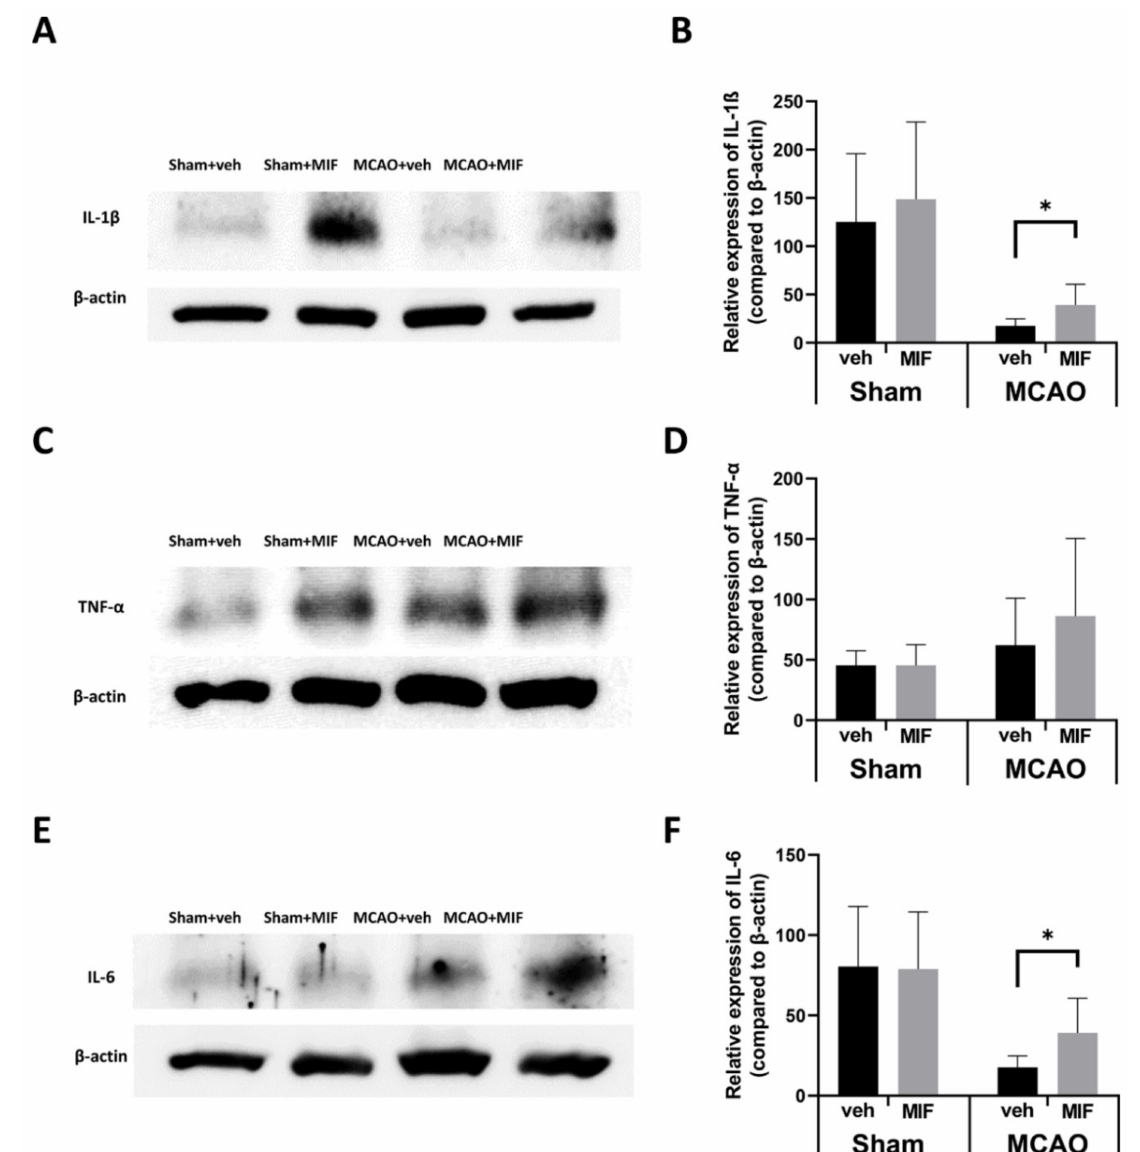
Figure 6. Changes of pro-inflammatory markers: ( A , C , E ) representative Western blot bands for each group; ( B ) expression level of IL-1 β between the sham+MIF and the sham+veh groups was not significantly different ( p = 0.909); the IL-1 β expression in the MCAO+MIF group was significantly facilitated compared to that in the MCAO+veh group (* p < 0.003); ( D ) the expression level of TNF- α expression was not significantly increased following MIF administration in the MCAO group ( p = 0.383) and in the sham group ( p = 0.992), respectively; ( F ) IL-6 expression in the MCAO+MIF group was significantly increased compared to the MCAO+veh group (* p < 0.004); there was no significant difference between sham groups ( p = 0.916). Pro-inflammatory marker expression of all sham and MACO groups was analyzed, respectively, with a t -test. Mean ± SD values are presented from 12 independent experiments. MCAO: middle cerebral artery occlusion; MIF: macrophage migration inhibitory